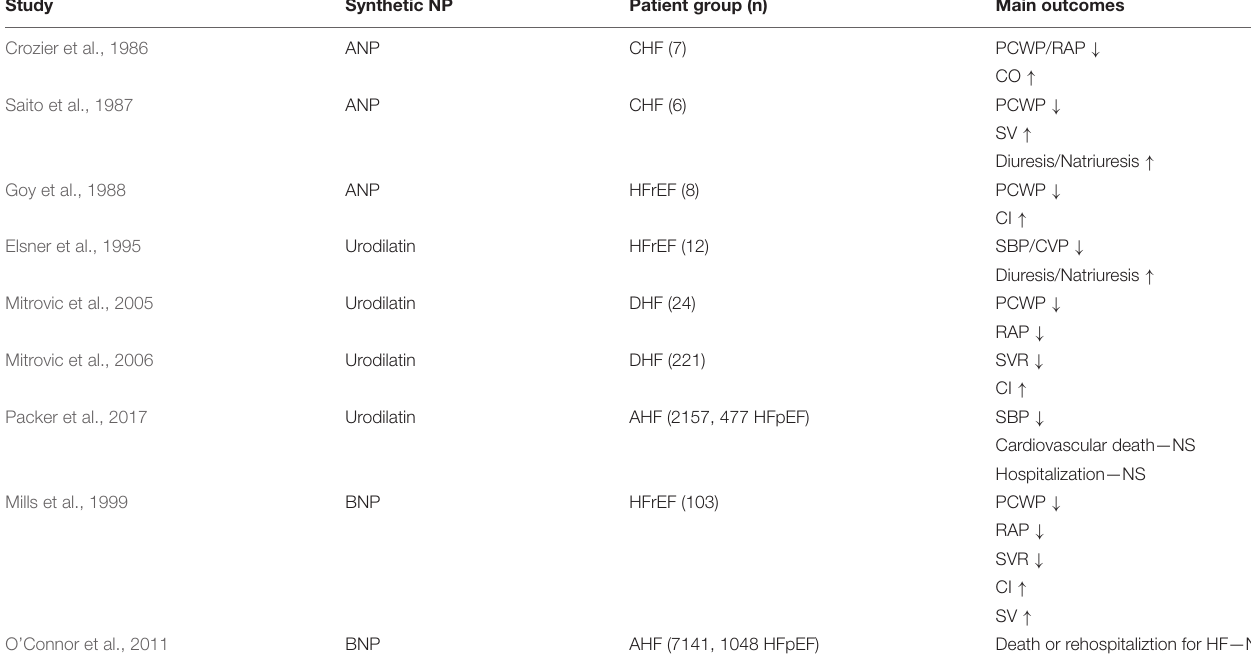
TABLE 1 | Clinical trials—synthetic NPs in HF.